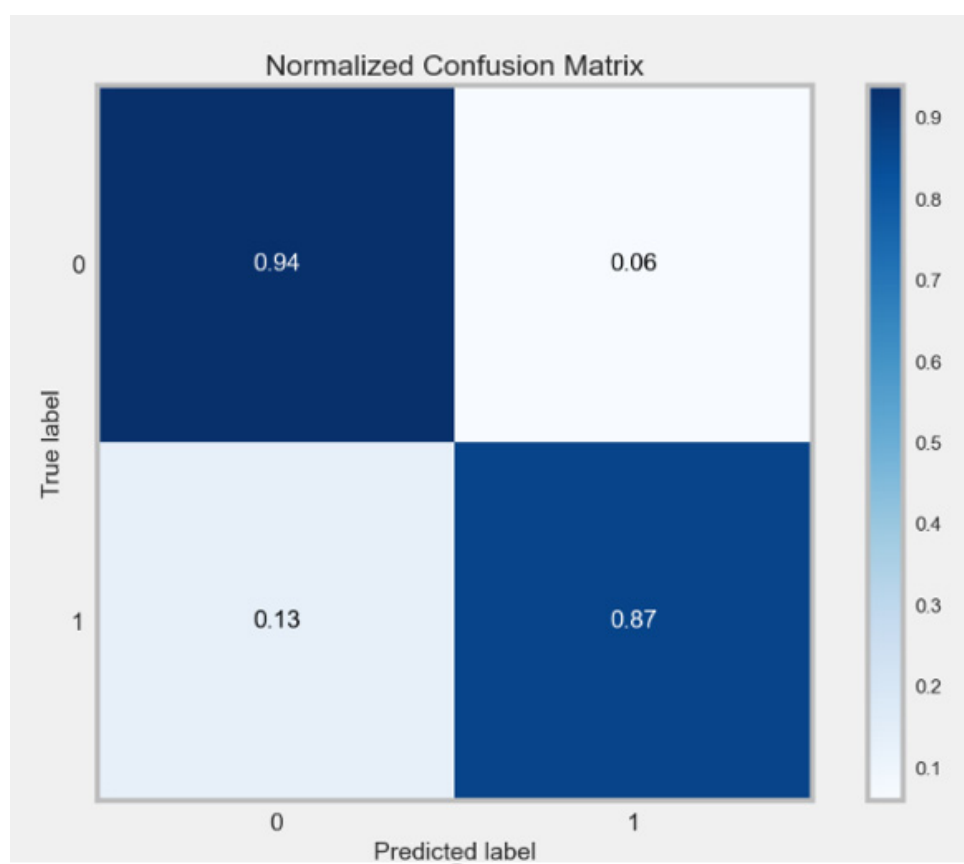
Figure 17. Precision–recall Curve for XGBoost model.